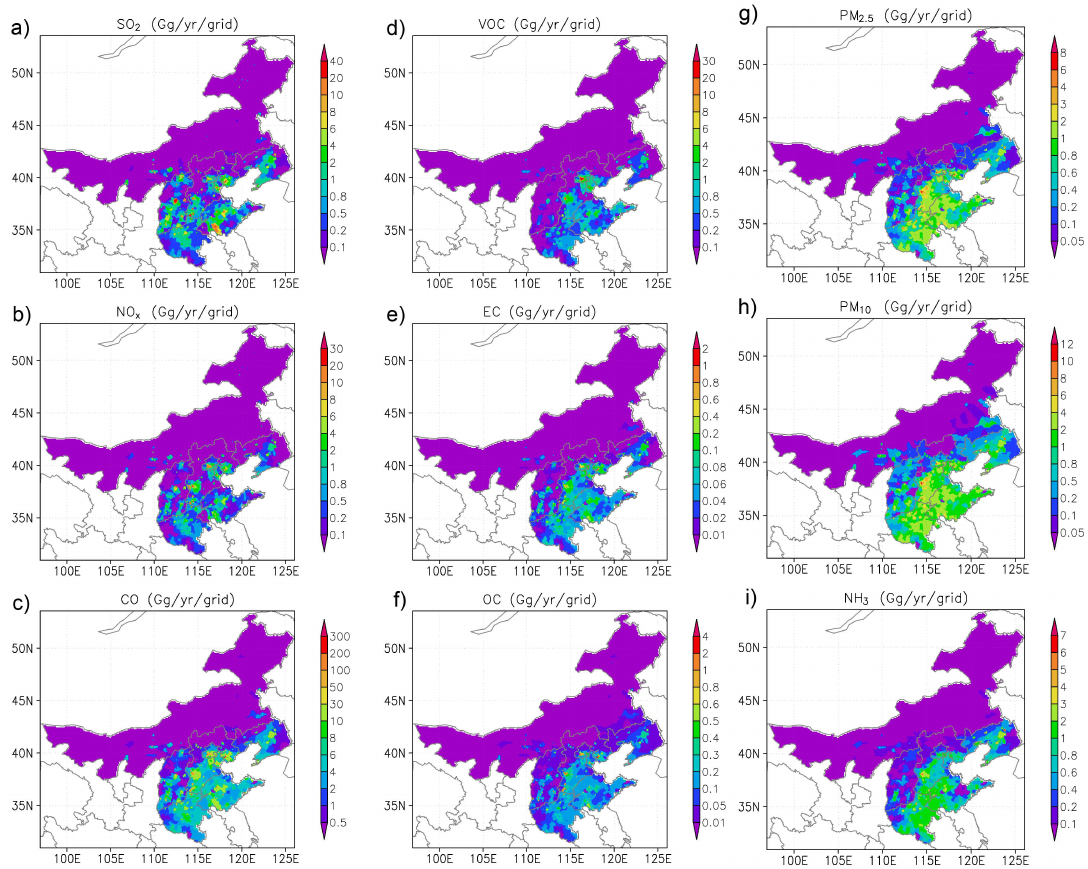
Fig. 4. Spatial distributions of anthropogenic emissions in the larger Huabei region for the year 2003. Units are Ggyr − 1 per grid with a cell size of 0.1 ◦ latitude × 0.1 ◦ longitude. Data are available in the Supplement.